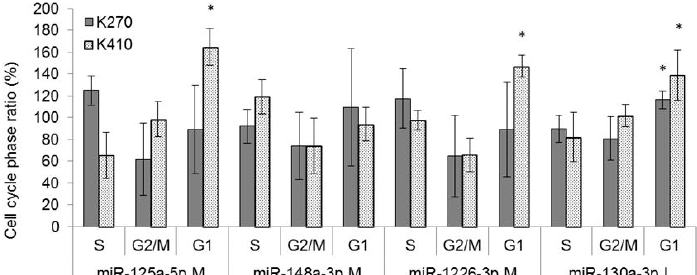
Figure 5. Specific miRNA signatures of resistant cell lines impact on cell cycle in ESCC. Cell cycle analysis of ESCC cells after transfection with respective miRNAs in KYSE-270 and KYSE-410. S: synthesis phase of DNA replication, G2: gap 2 between DNA synthesis and mitosis, M: mitosis